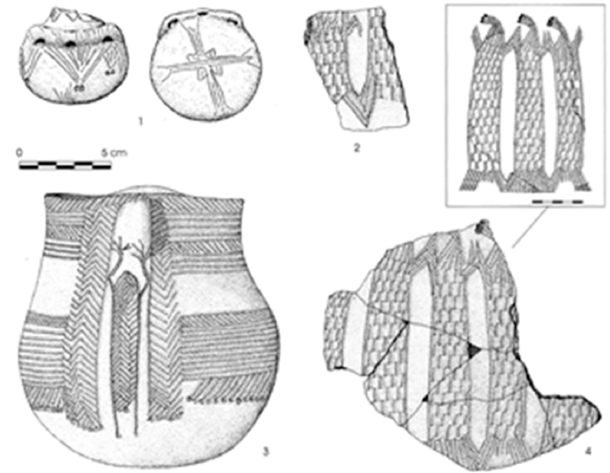
Figure 4. “Cardial” ceramics with anthropomorphic motifs. Source: (Martí Oliver et al. 2001, p. 64). Therefore, these last images present a ritual dance. The feathers of the dancers converge with the small